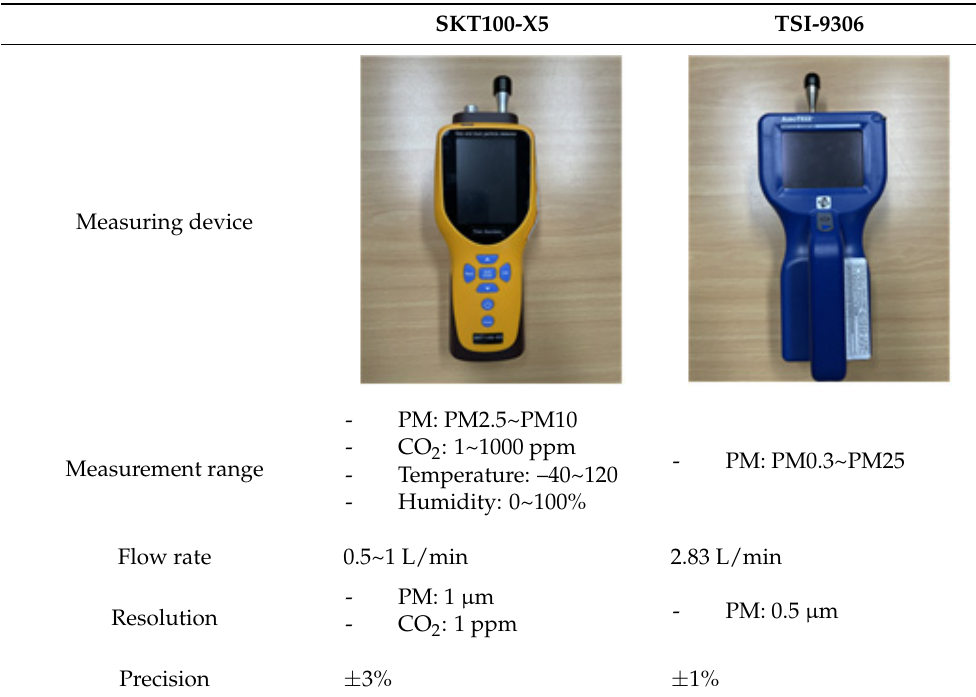
Table 3. Precision sensor details.